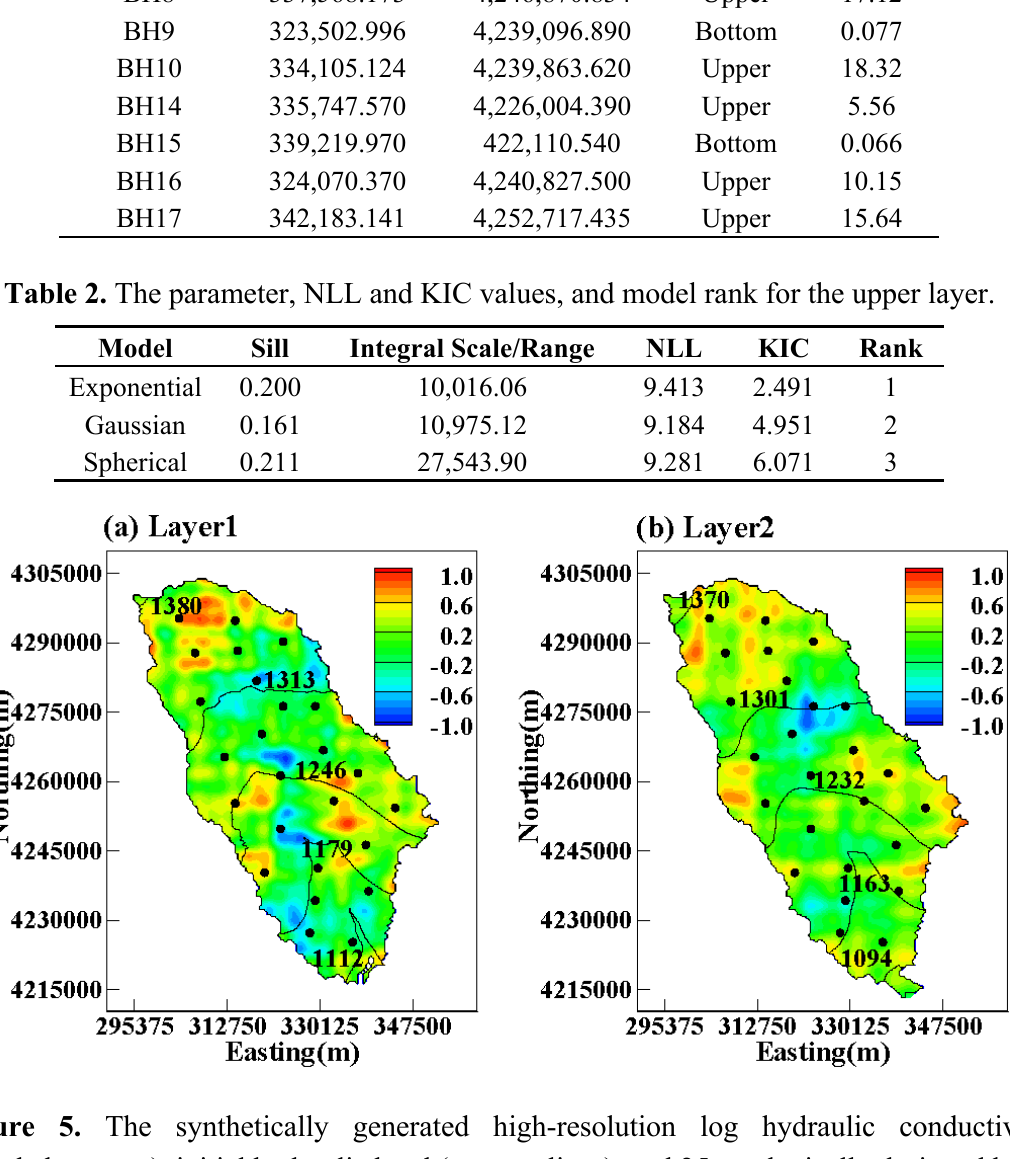
Figure 5. The synthetically generated high-resolution log hydraulic conductivity (flooded contour), initial hydraulic head (contour lines), and 25 synthetically designed head observation locations (black dots). ( a ) Layer 1; ( b ) Layer